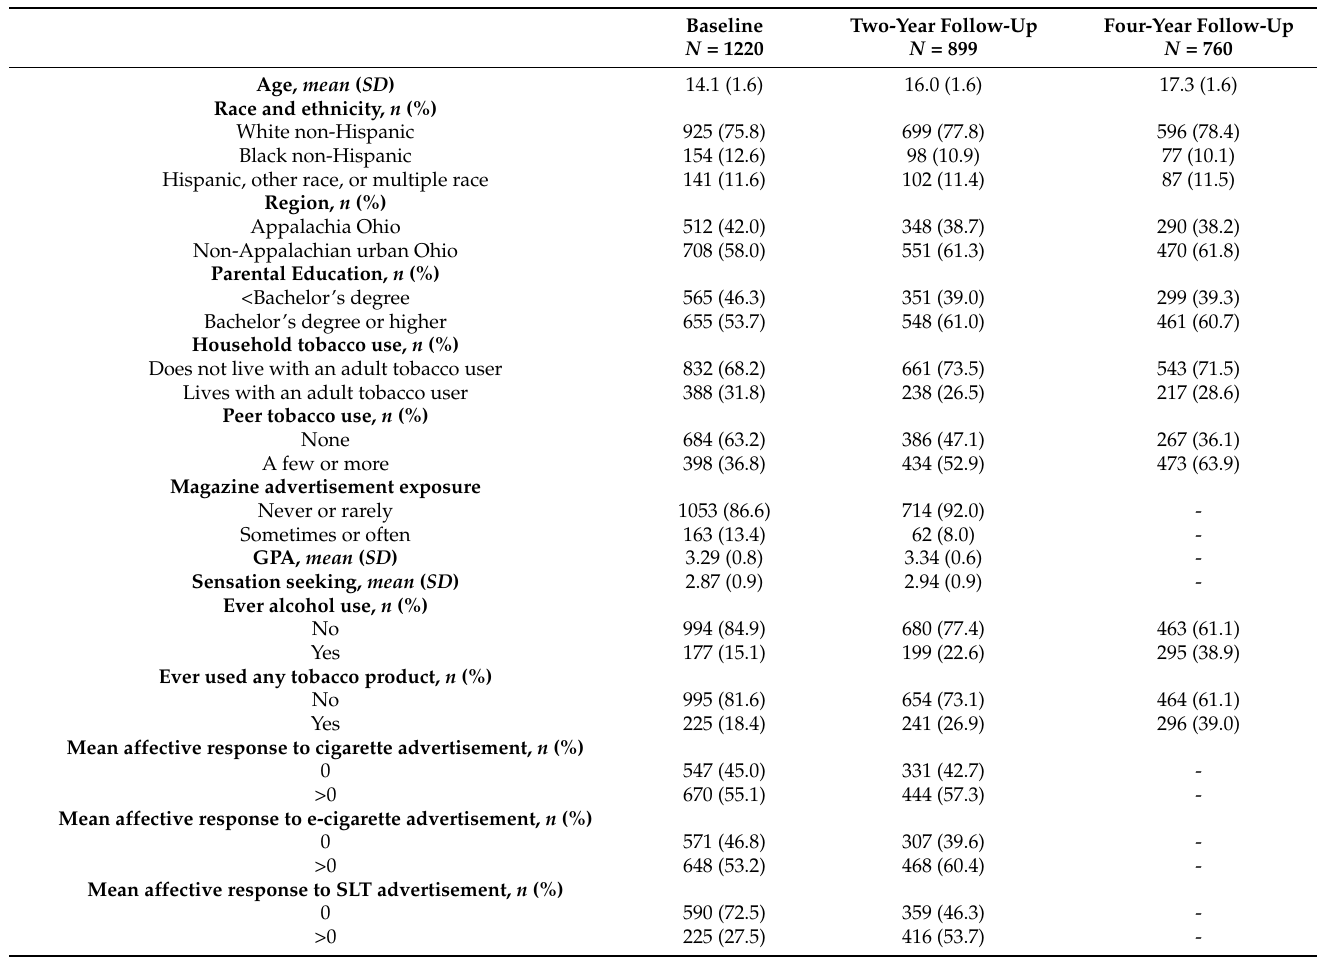
Table 1. Characteristics of male youth participants at baseline and two- and four-year follow-ups.